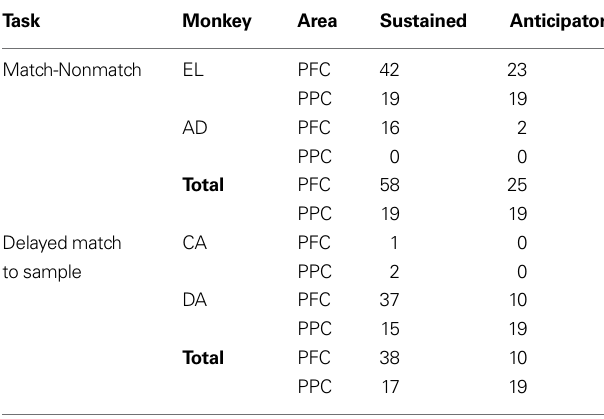
Table 1 | Number of neurons recorded in each area and monkey.